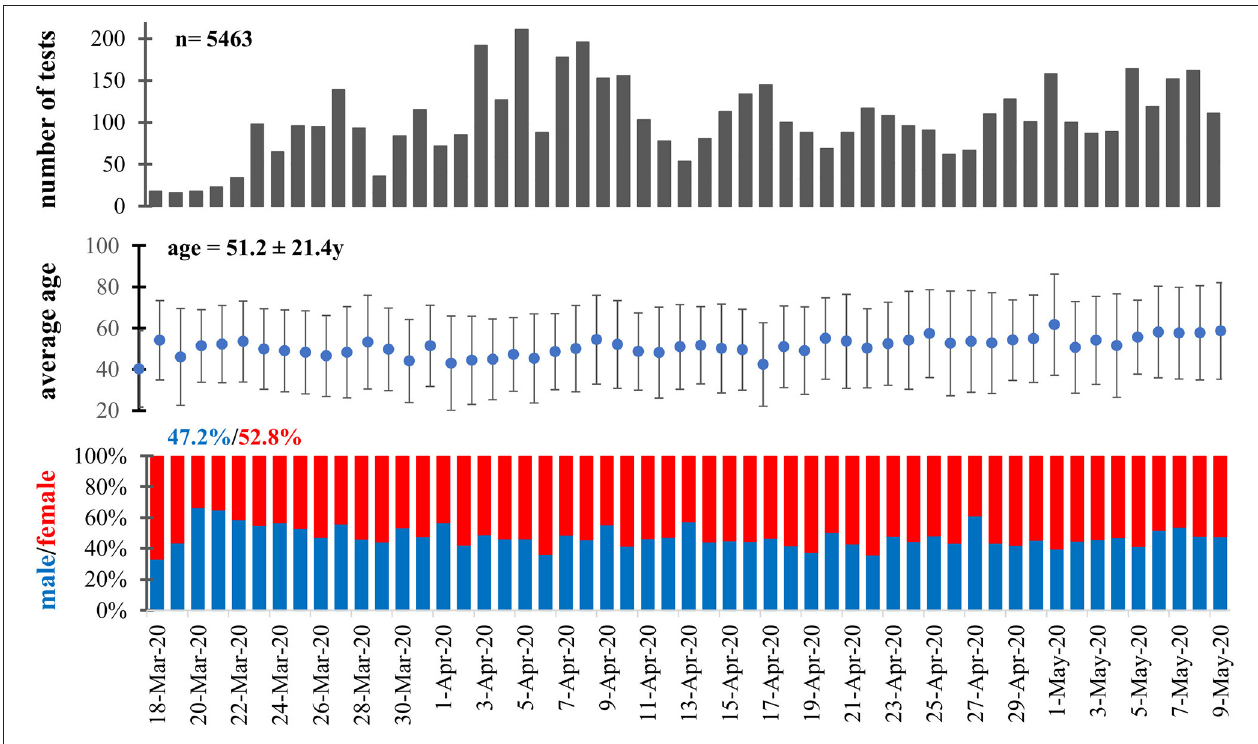
FIGURE 1 | Age and sex distribution of the study population during the observation period.